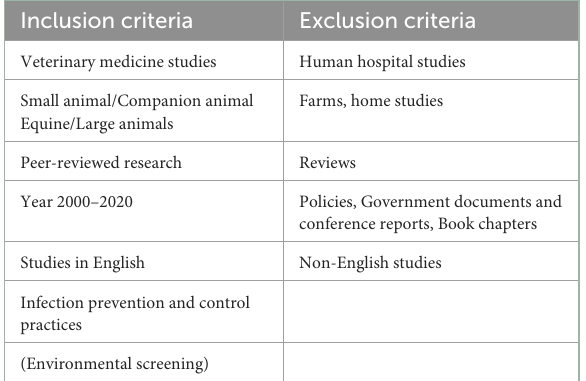
TABLE 1 Search terms and databases utilized to search for articles included in this review about hospital-acquired and/or zoonotic infections in veterinary facilities between 2000 and 2020.